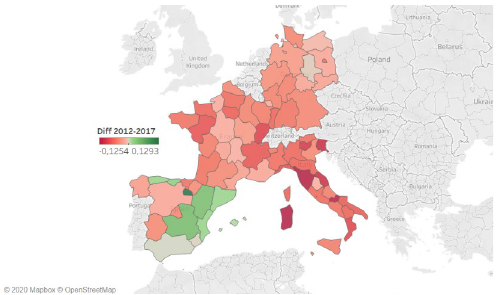
Fig 4. Variation (2012–2017) of the number of hospital beds per 100.000 inhabitants. Each region is coloured on the basis of the difference between the number of beds in 2012 and in 2017: dark red reported the highest reduction (i.e. Sardegna), dark green reported the highest increase (i.e. La Rioja) (map was created on the basis of Eurostat data [23] using Tableau Software; Seattle, Washington, United